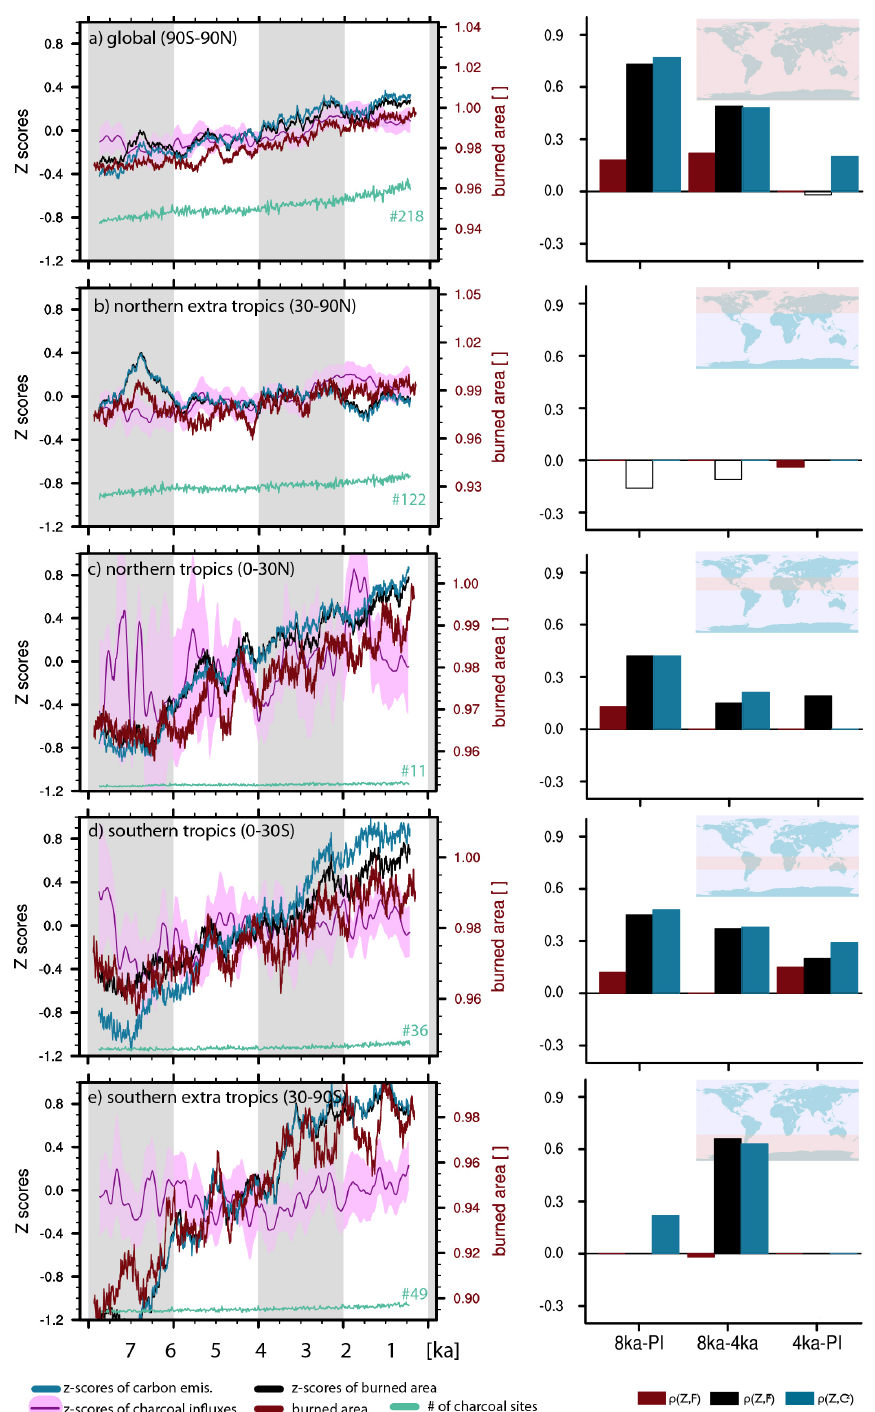
Fig. 3. Averaged values for reconstructed and modelled biomass burning during the present interglacial as global values (a) , for extra tropics (b, e) , and tropics (c, d) separately. Reconstructions are shown by Z -scores of charcoal influxes ( Z , pink), and Z -score transformed values of modelled burned area ( F Z , black) and carbon emissions by fire ( C Z , blue). Untransformed model output of burned area ( F , red) and the number of sites used in the reconstructions (green) are also given. For all time series a running mean of 250yr is applied. Please note the varying, relative scale of modelled burned area. The scale for the modelled Z -scores of burned area is determined by the maximum amplitude of Z -score transformed charcoal influxes (reconstructions). On the right side, the corresponding rank correlations ρ (after Spearman) are shown. Significant, positive values are given by filled bars for three different time windows: 8ka–PI, 8–4ka, and